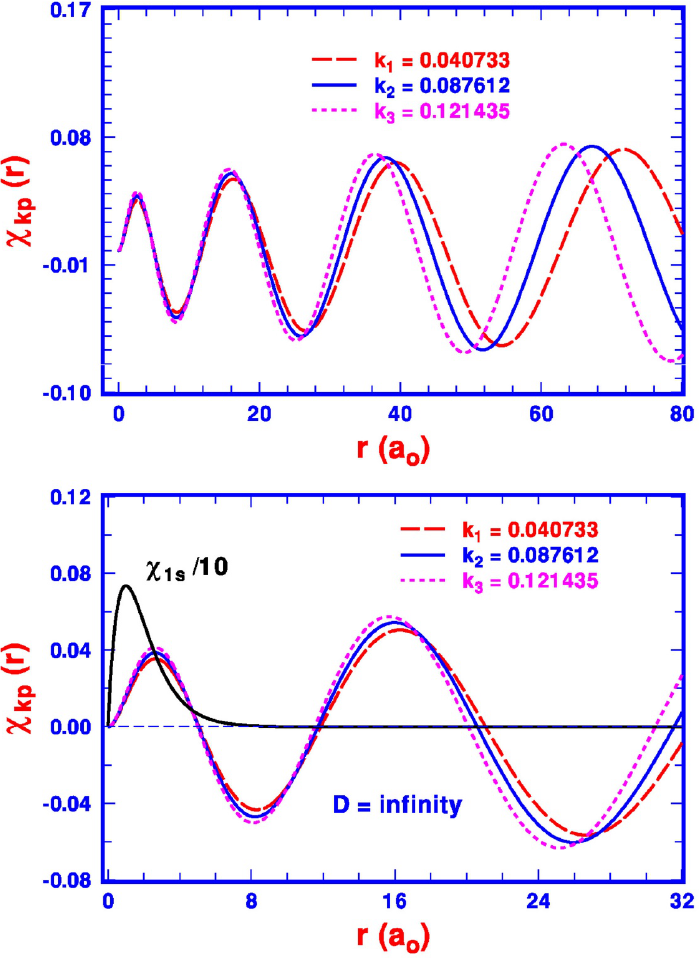
Figure 6. The radial functions χ kp of the outgoing ionized p electron from the plasma-free hydrogen at a number of momenta. The bottom plot compares χ kp to χ 1 s (reduced by a factor of 10) at small r